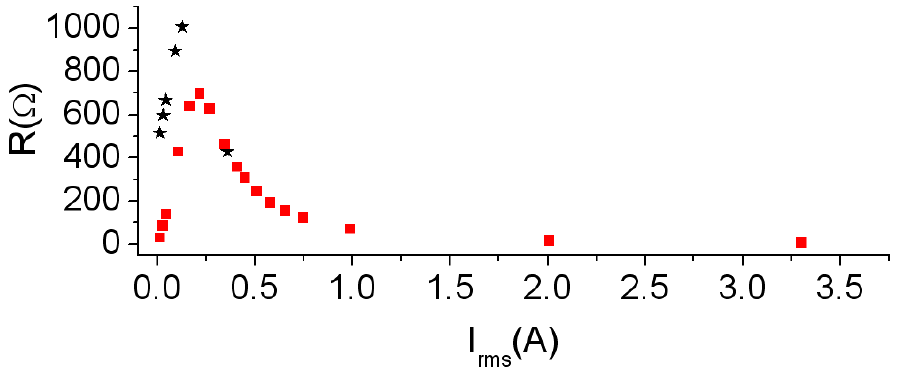
curve. Experiment (– *–) and 2D simulation ( – ■ – rms